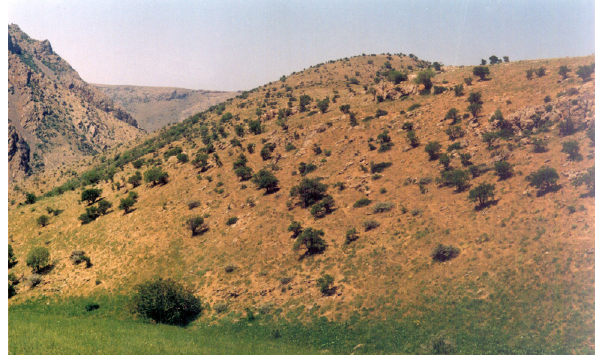
Fig. 9. Amygdalus pabotii-Acer community